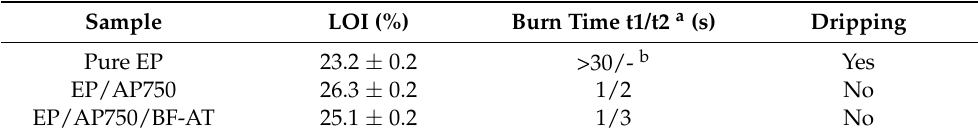
Table 3. Limiting oxygen index (LOI) and UL-94 results of flame retardant modified fiber epoxy